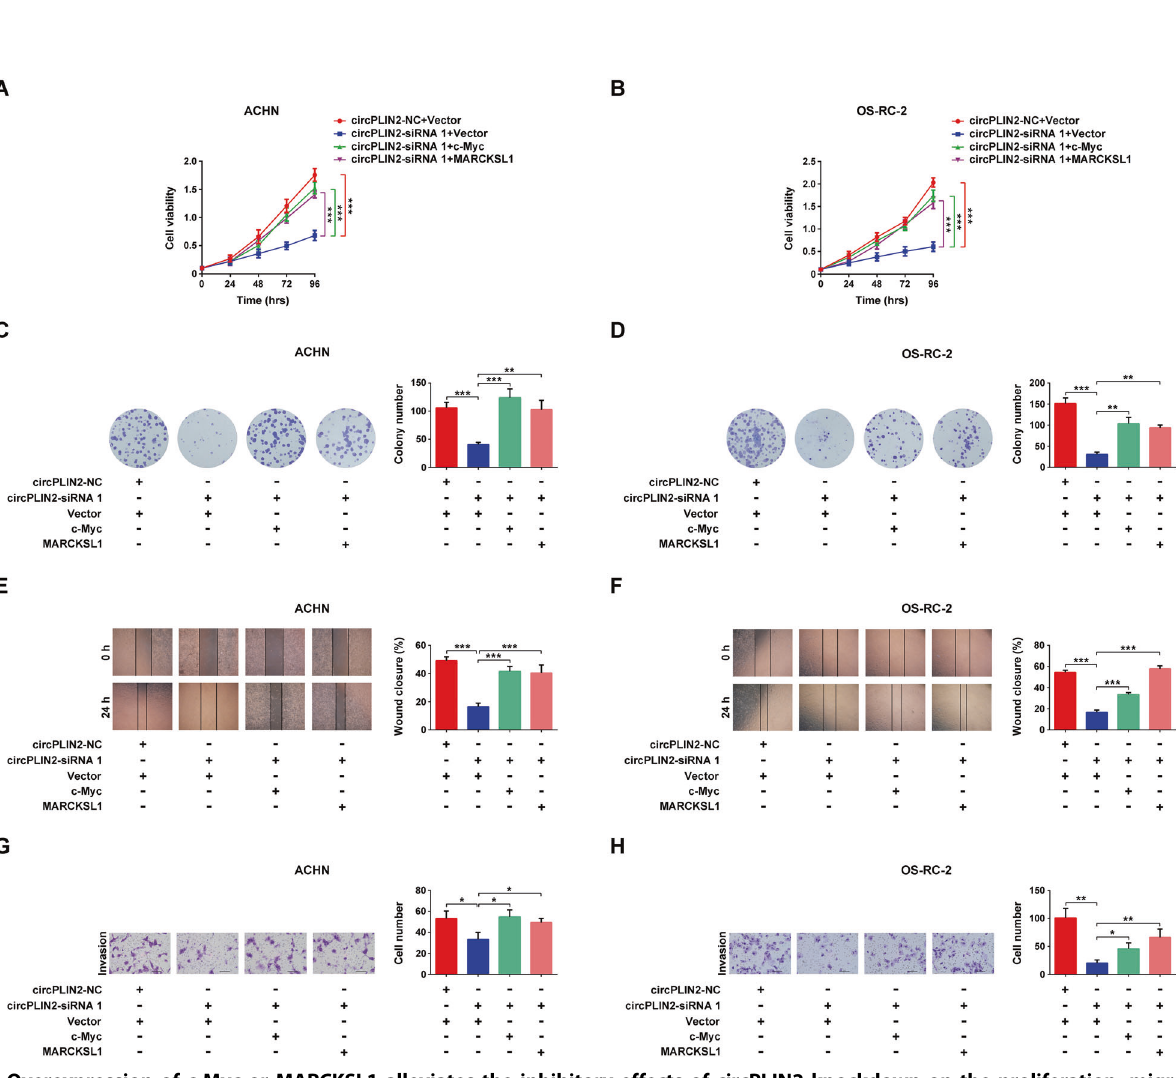
Fig. 5 Overexpression of c-Myc or MARCKSL1 alleviates the inhibitory effects of circPLIN2 knockdown on the proliferation, migration, and invasion of ccRCC cells in vitro. A , B CCK-8 cell viability assays for ACHN ( A ) and OS-RC-2 ( B ) cells transfected with circPLIN2-siRNA 1 or circPLIN2-NC and c-Myc/MARCKSL1 or vector. C , D Colony formation assays for ACHN ( C ) and OS-RC-2 ( D ) cells transfected with circPLIN2- siRNA 1 or circPLIN2-NC and c-Myc/MARCKSL1 or vector. The number of colonies was determined. E , F Wound-healing assays for ACHN ( E ) and OS-RC-2 ( F ) cells transfected with circPLIN2-siRNA 1 or circPLIN2-NC and c-Myc/MARCKSL1 or vector. The wound closure rate was calculated. Magni fi cation, ×40. G , H Matrigel-coated Transwell assays for ACHN ( G ) and OS-RC-2 ( H ) cells transfected with circPLIN2-siRNA 1 or circPLIN2- NC and c-Myc/MARCKSL1 or vector. The cell number per fi eld was quanti fi ed. Scale bar, 100 μ m. Two-tailed Student ’ s t test. The error bars represent S.D. ** p < 0.01 and *** p < 0.001. Cell Death and Disease (2022)